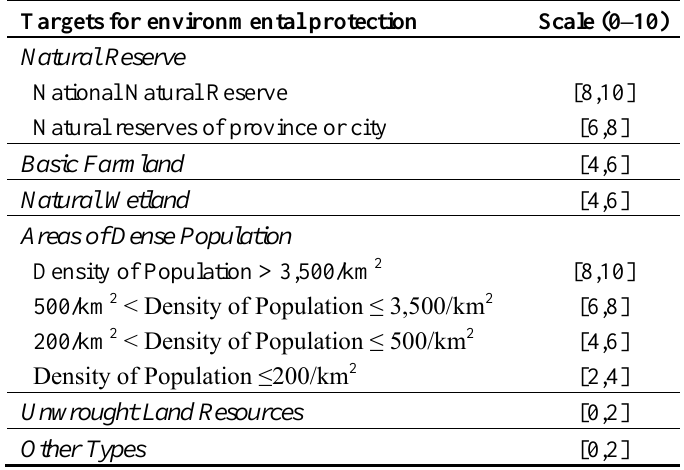
Table 1. Grading for different targets in terms of environmental